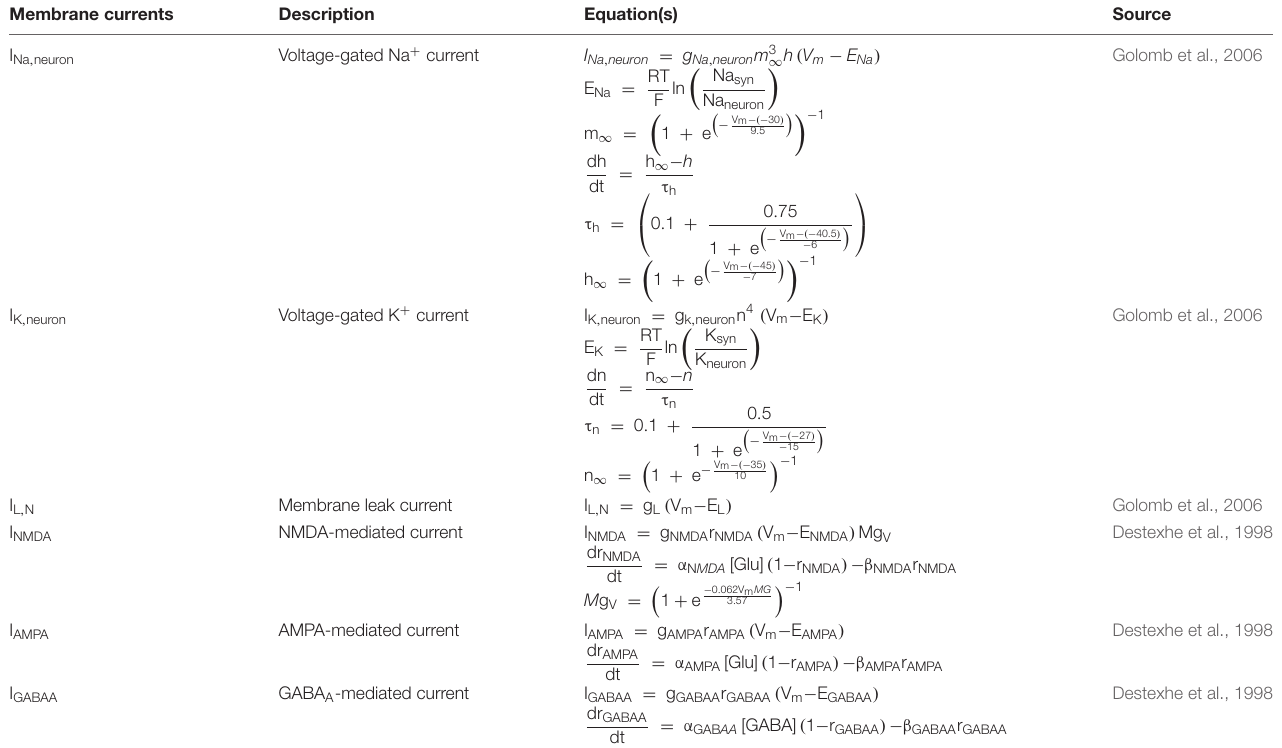
TABLE 1 | Neuron membrane dynamics. Membrane currents